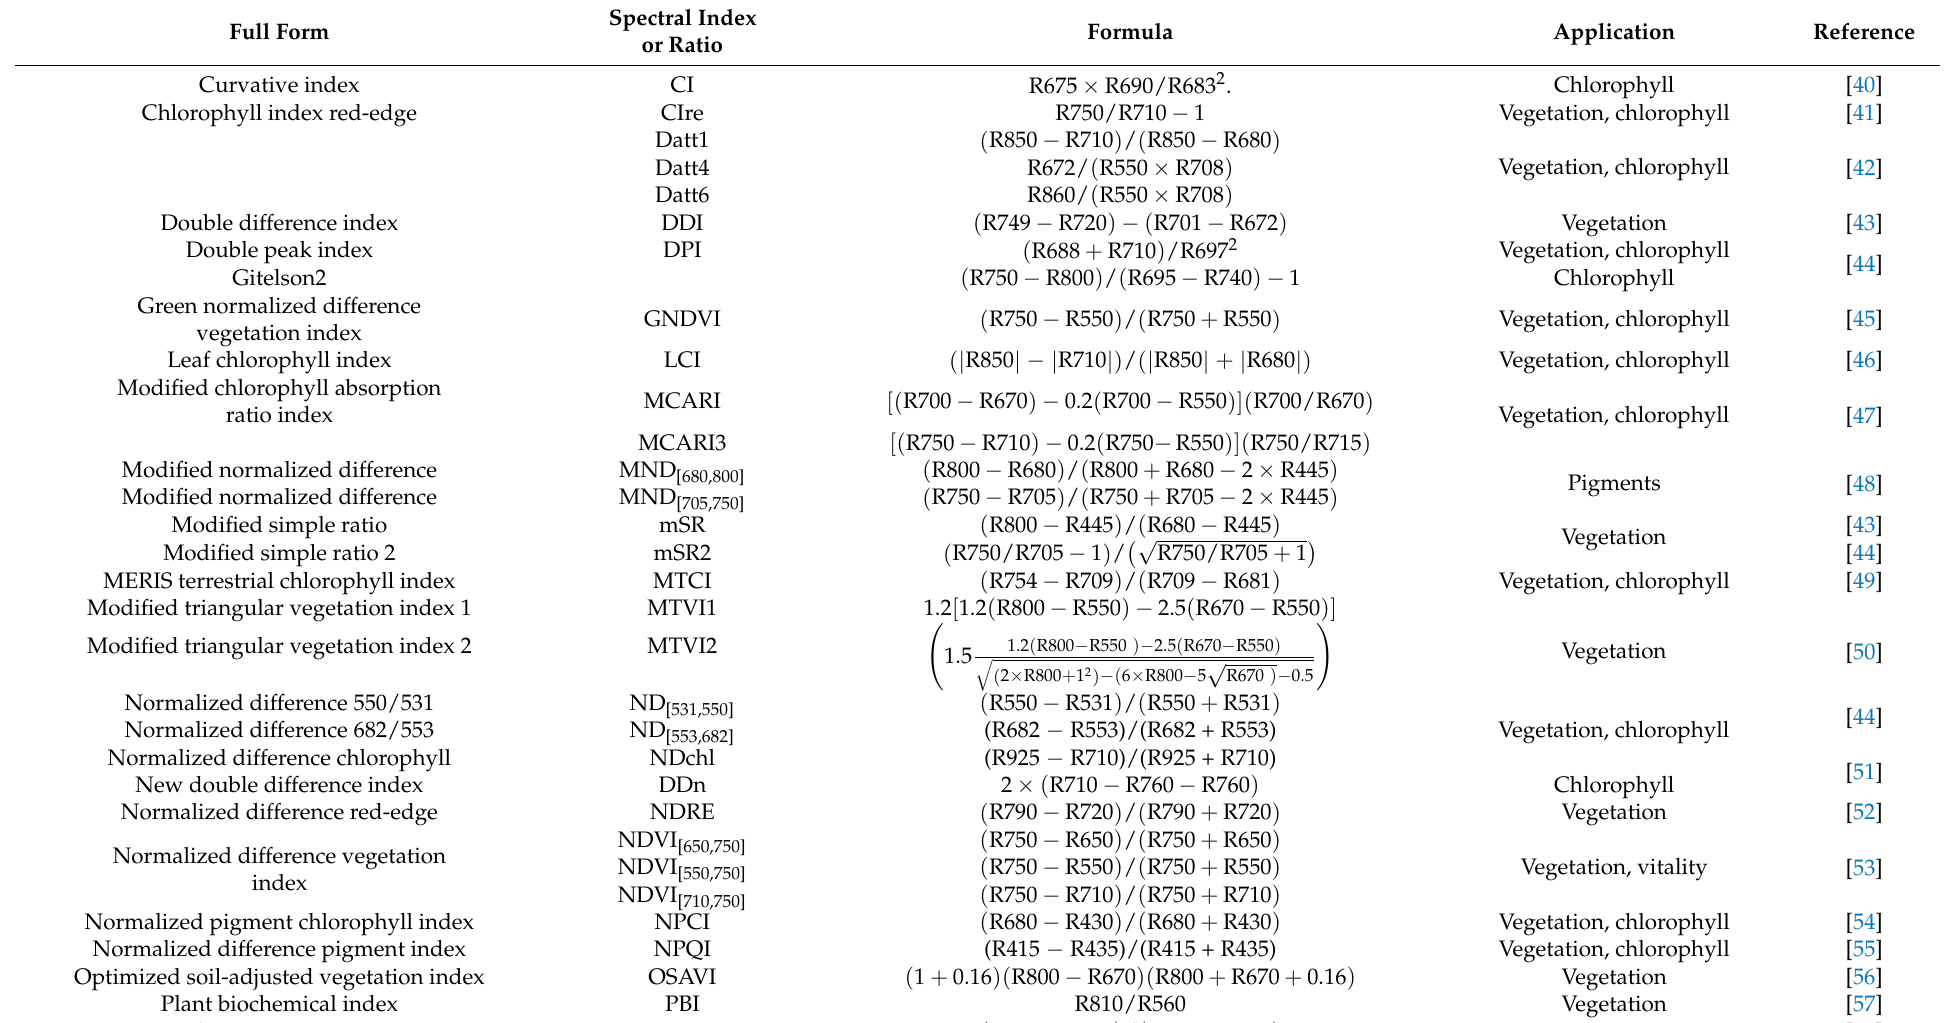
Table 2. Summary of the 60 spectral indices explored in this